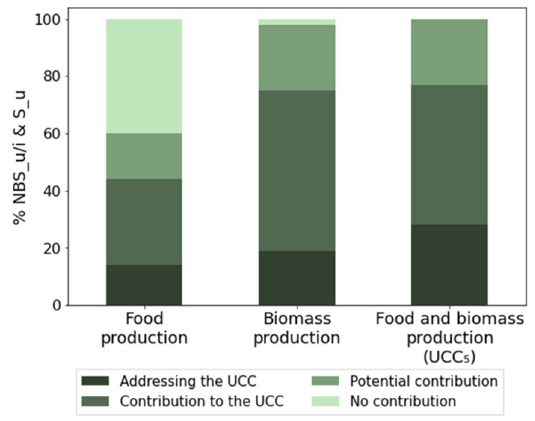
Figure 2. Colum chart representing the selected 43 NBS_u/i and S_u and categorized as those addressing, contributing, and potentially contributing to the UCC 5 on “Food and biomass production”, respectively.